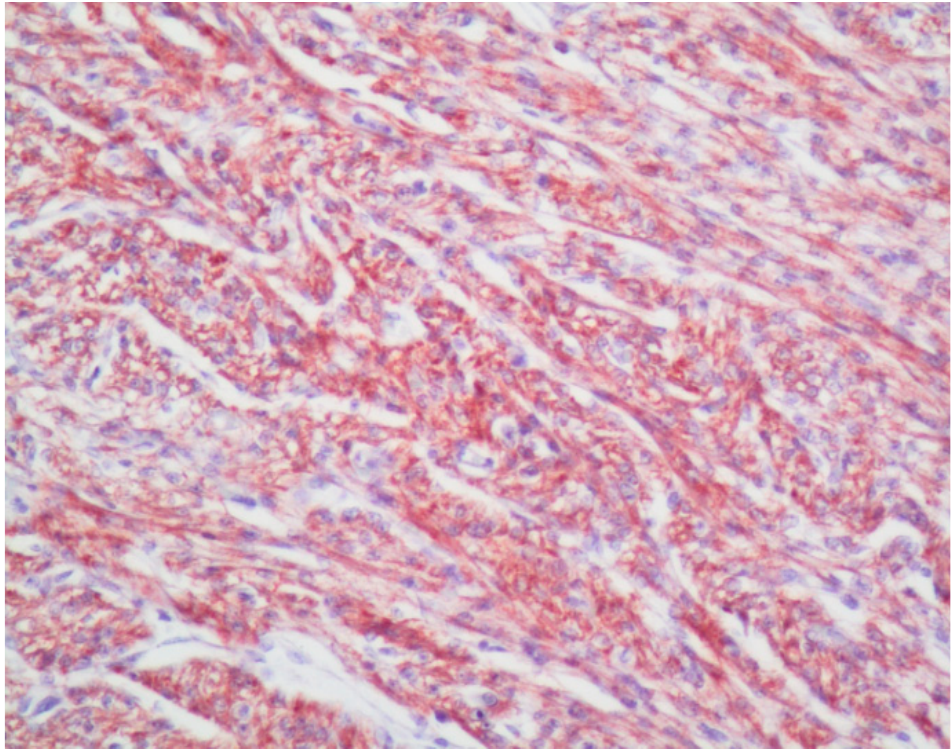
Figure 1. Diffuse cytoplasmic VDAC1 staining of the human myocardium served as the positive control (VDAC1 magnification ×100).